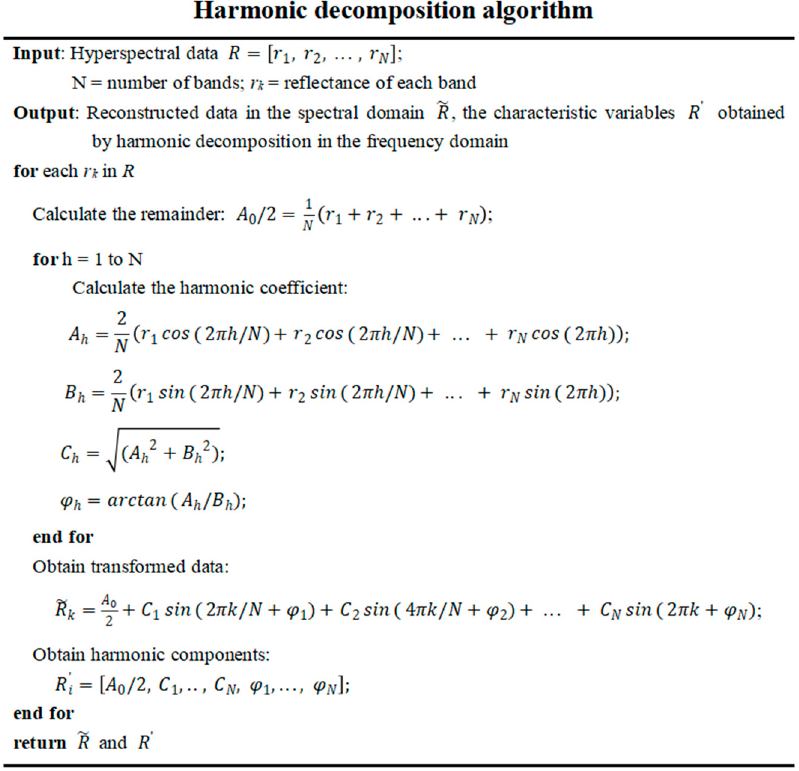
Figure 2. Illustration of the harmonic decomposition algorithm in pseudo-code.